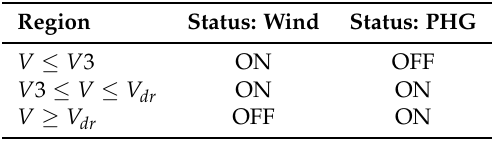
Table 2. Operating conditions on the extended curve region.